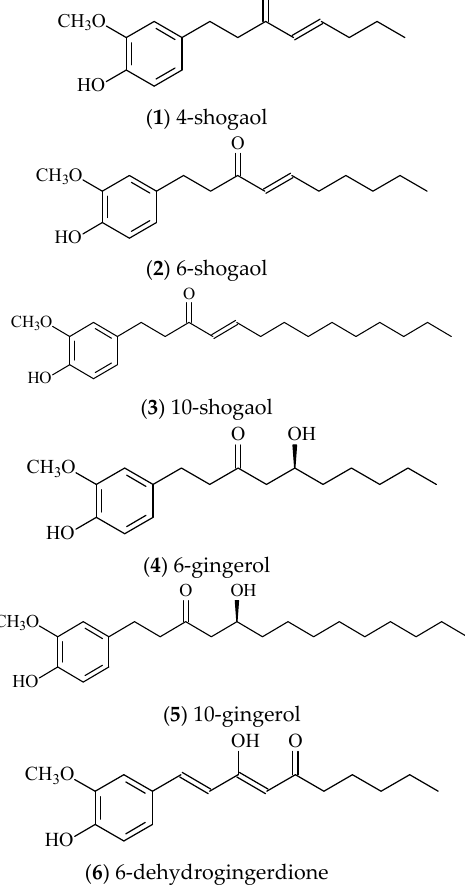
Figure 1. The chemical structure of 4-shogaol ( 1 ), 6-shogaol ( 2 ), 10-shogaol ( 3 ), 6-gingerol ( 4 ), 10-gingerol ( 5 ), and 6-dehydrogingerdione ( 6 ).